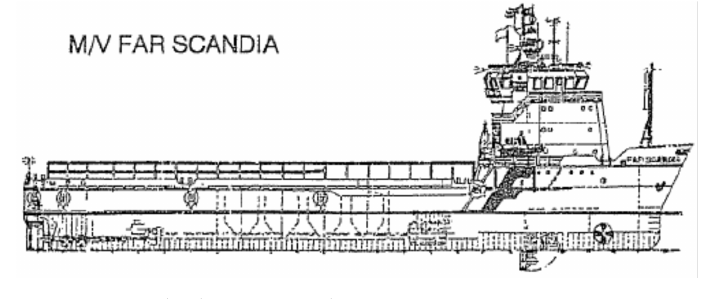
Figure 3. Supply ship Far